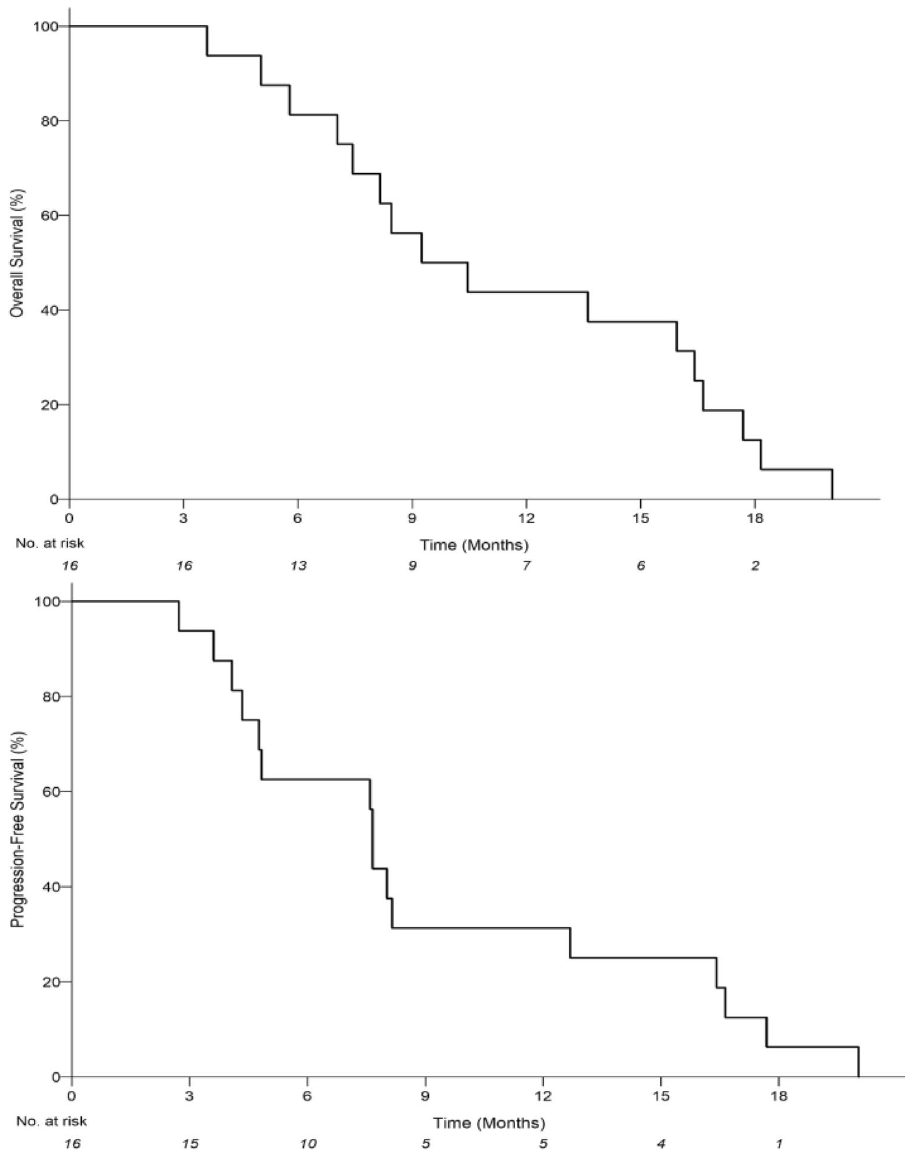
Figure 2. Kaplan–Meier estimates of the probability of progression-free survival (PFS) for evaluable patients receiving intervention. Median PFS is 7.66 months (95% CI 4.34–12.70) with an estimated 12-month PFS rate of 31.25% (95% CI: 11.39–53.65) (top). Kaplan–Meier estimates of the probability of overall survival (OS) for evaluable patients receiving intervention. Median OS is 9.85 months (95% CI 7.04–16.41) with an estimated